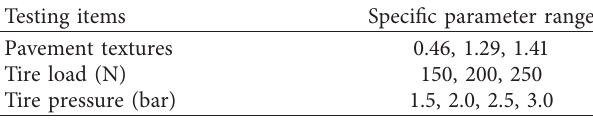
Table 3: The single-factor testing conditions of dynamic friction coefficient.